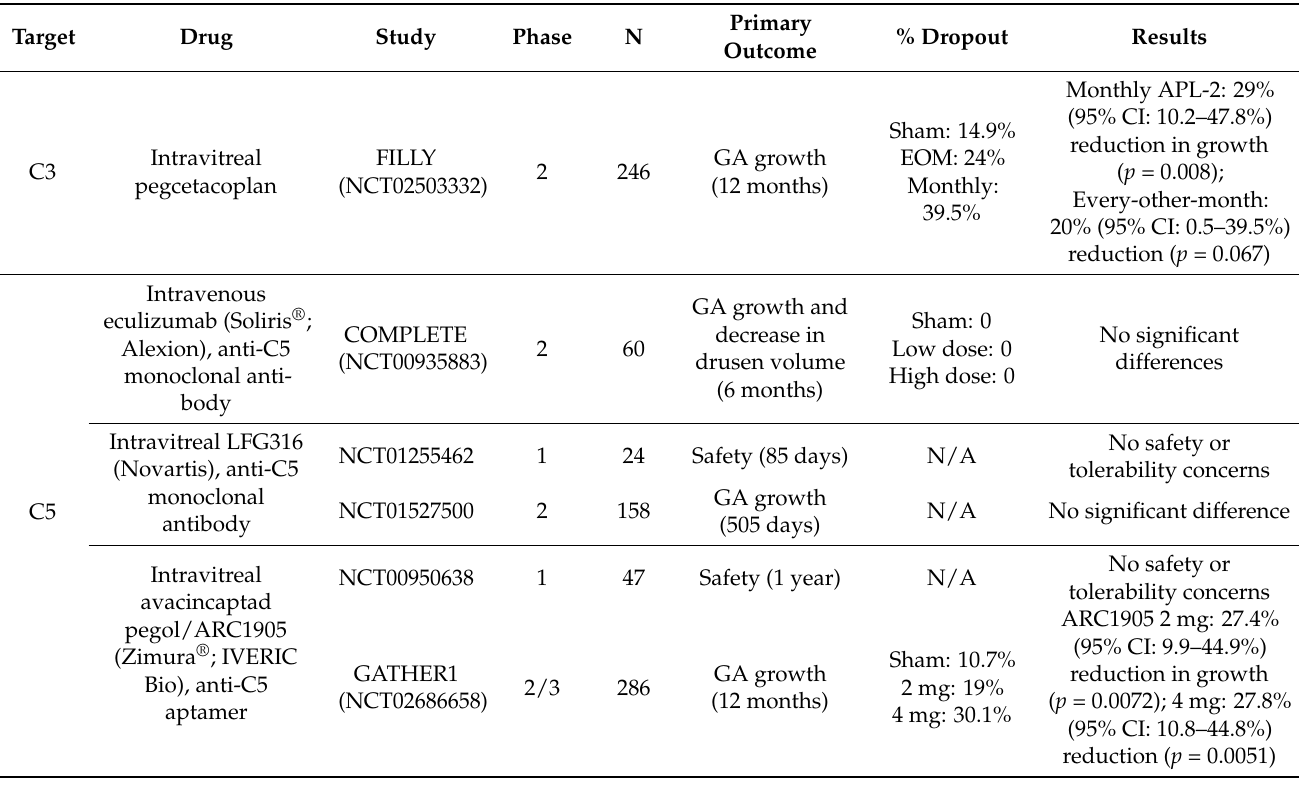
Figure 1. Timeline of complement inhibitor trials evaluating safety and efficacy in geographic atrophy to-date, organized by their complement protein targets. Table 1. Completed studies designed to evaluate complement modulation as a novel therapeutic strategy for geographic atrophy (GA); results are current as of March 2021 based on reviewing clinicaltrials.gov.